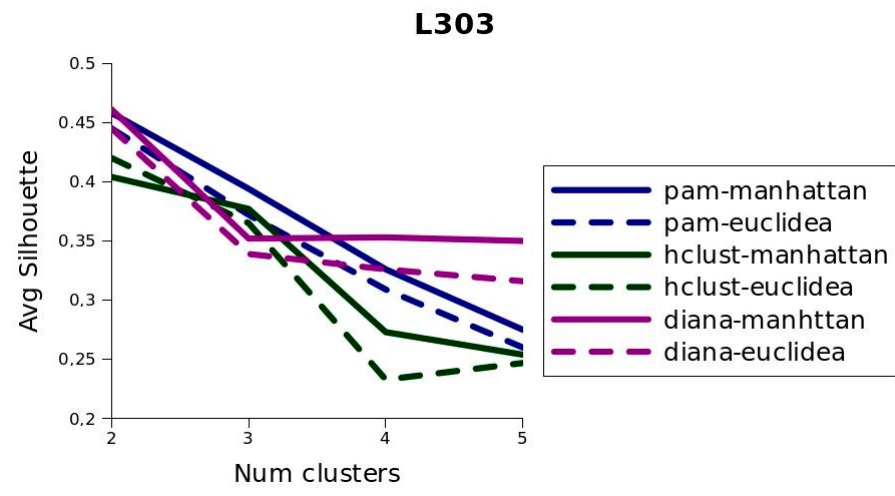
Figure 3. Average silhouette obtained in each of the groupings performed.